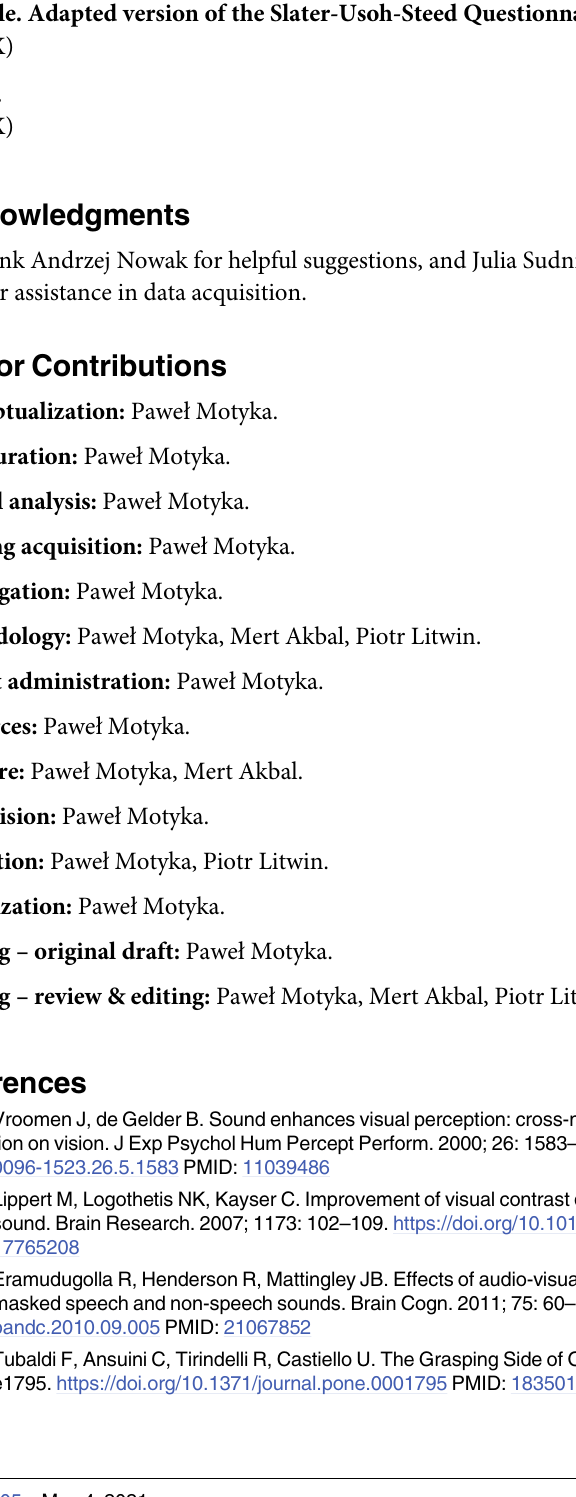
S1 Table. Shortened version of the Simulator Sickness Questionnaire (SSQ). The subject is instructed: “Please rate the extent to which you are experiencing now each of the symptoms”. S2 Table. Adapted version of the Slater-Usoh-Steed Questionnaire (SUS).